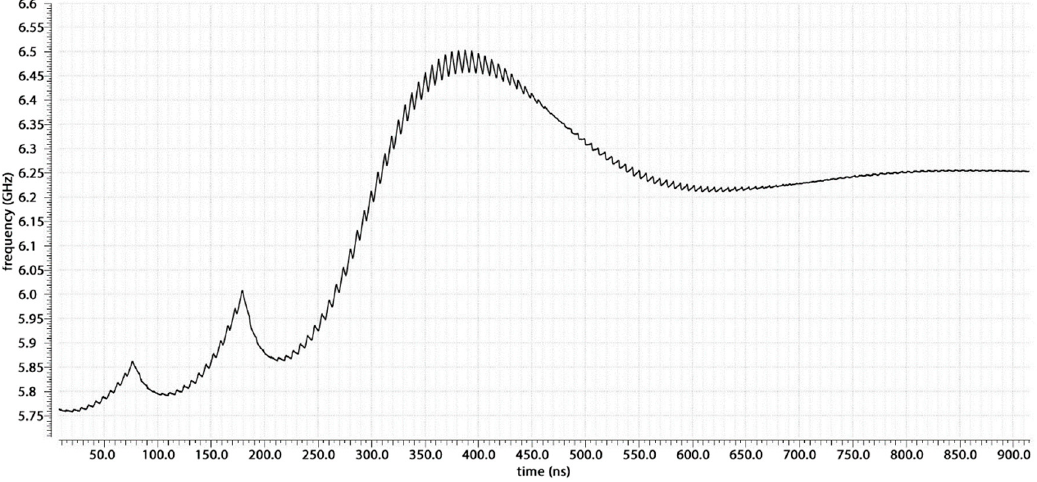
Figure 20. Post-layout locking process.